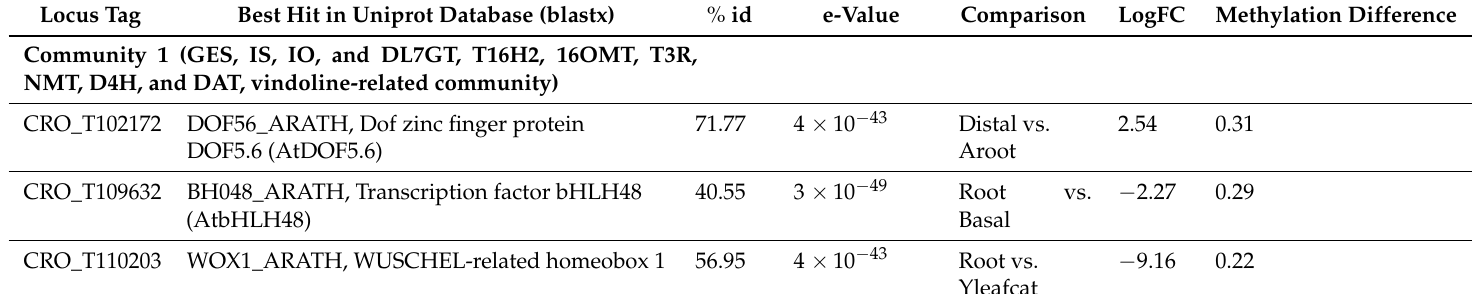
Table 1. Description of differentially expressed and methylated transcription factors co-expressed with MIA genes. Expression LogFC and methylation differences are given for the most contrasting